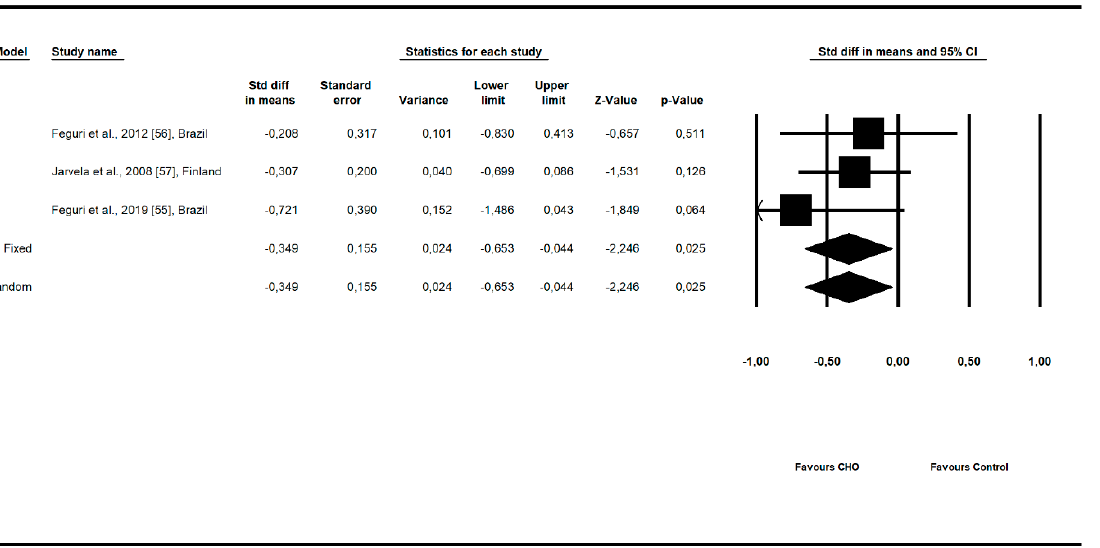
Figure 5. An effect size, difference in means, for intensive care unit (ICU) stay (hours) in patients